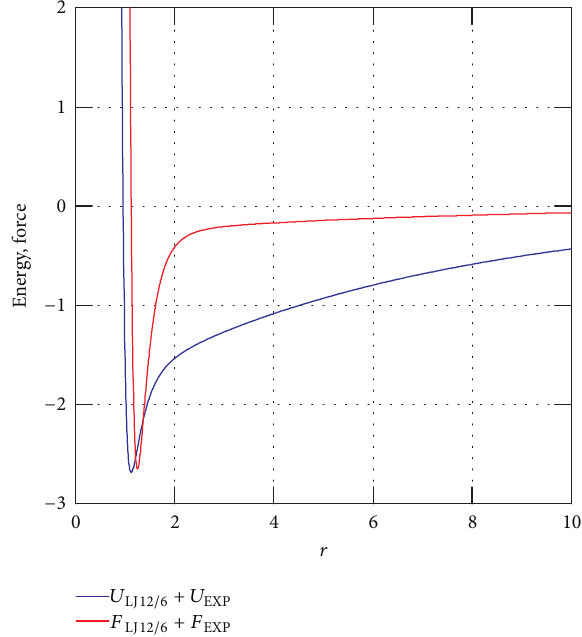
Figure 3: Energy, force relationship of nonfunctional bead to nonfunctional bead, nonfunctional bead to functional bead, and nonfunctional bead to DLC C atoms as a function of 𝑟 .